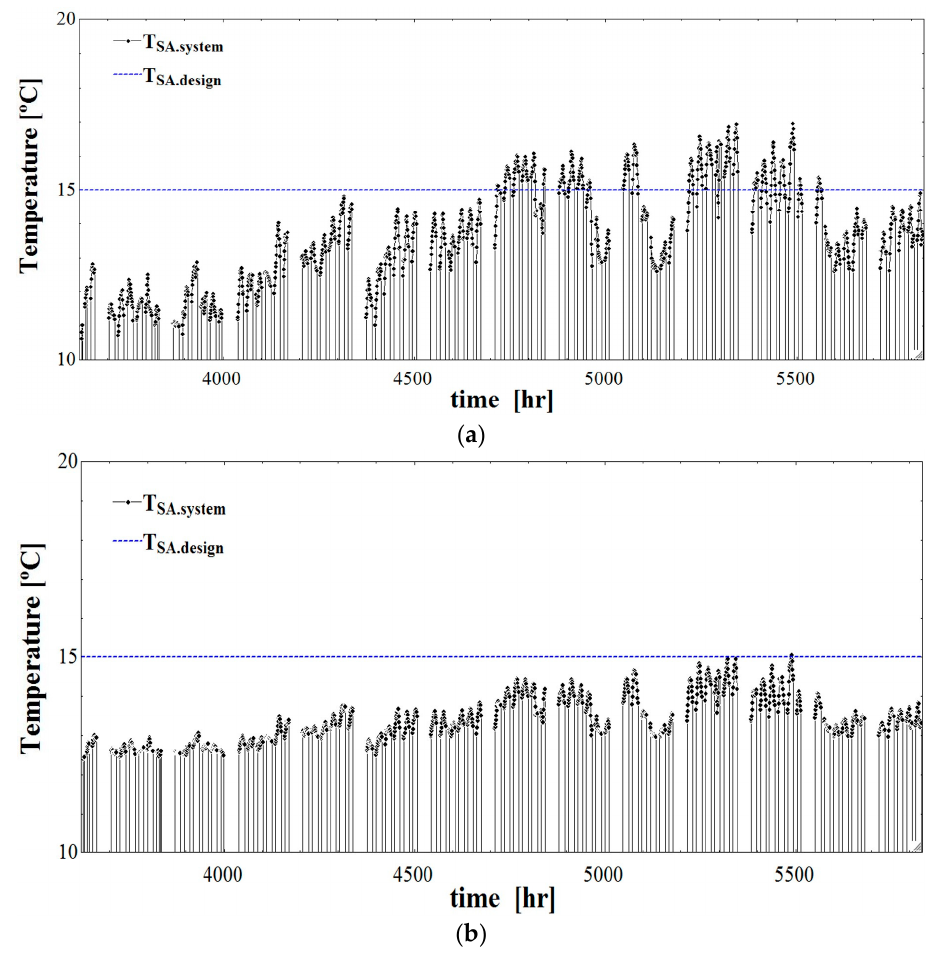
Figure 9. SA temperature in the systems in summer season. ( a ) SA temperature of the conventional LD-IDECOAS; ( b ) SA temperature of the proposed HPLD-IDECOAS.